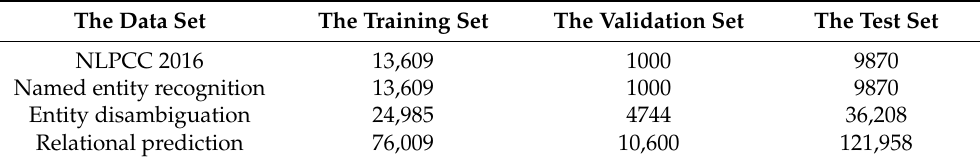
Table 3. Dataset